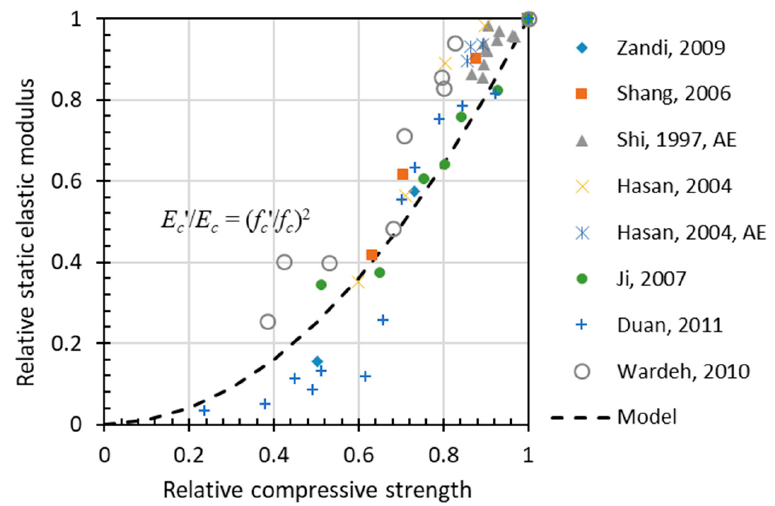
Figure 10. Simple correlation between relative Ec and relative fc.